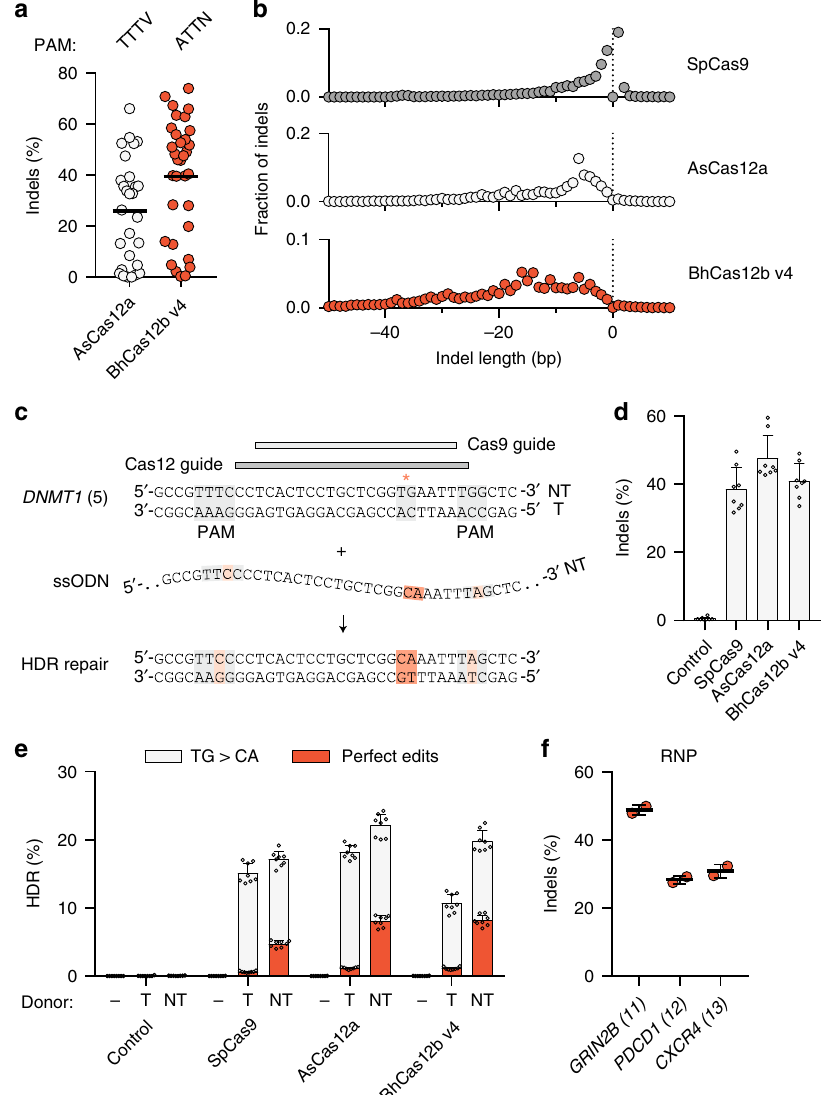
Fig. 3 BhCas12b v4 mediates genome editing in human cells. a Indel activity in 293T cells of AsCas12a at 28 TTTV targets and BhCas12b v4 at 33 ATTN targets. Each dot represents a single target site, averaged from n = 4 replicates. b Average indel length during genome editing with 30 active BhCas12b guides, 45 active AsCas12a guides, and 39 active SpCas9 guides. c Schematic of a DNMT1 region targetable by SpCas9 and Cas12a/b nucleases and a 120- nt ssODN donor containing a TG-to-CA mutation and PAM-disrupting mutations. d Indel activity of each nuclease at the DNMT1 locus. Error bars represent s.d. from n = 8 replicates. e Frequency of homology-directed repair (HDR) using a target strand (T) or non-target strand (NT) donor. Gray bars indicate the frequency of TG-to-CA mutation, while red bars indicate perfect edits with no detectable mutations in the 36-nt sequence shown in panel c . Error bars represent s.d. from n = 6 replicates. f Indel activity in CD4 + human T cells following BhCas12b v4 RNP delivery. Each dot represents an individual electroporation ( n = 2). Source data are provided as a Source Data fi